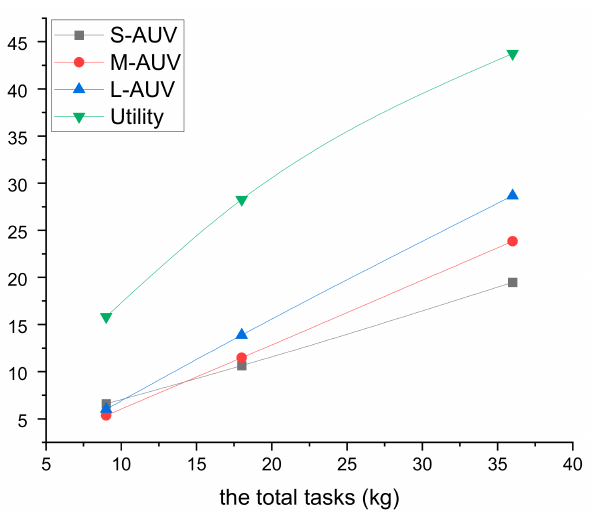
Figure 5. The line chart of the values simulated in the large-scale system under three different w total